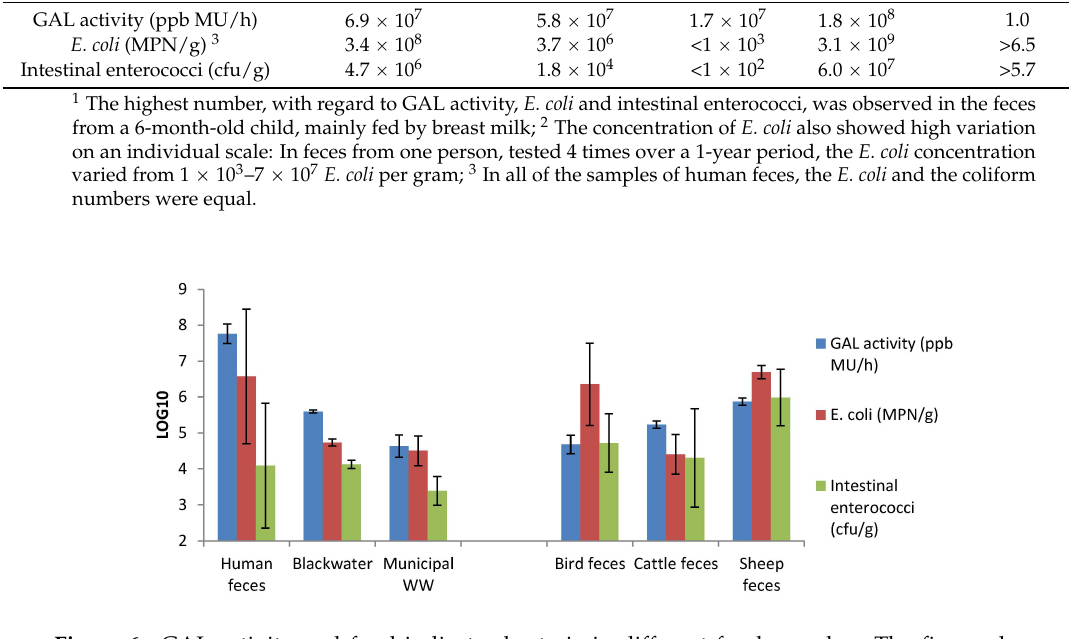
Figure 6. GAL activity and fecal indicator bacteria in different fecal samples. The figure shows logarithmic values (average ˘ standard